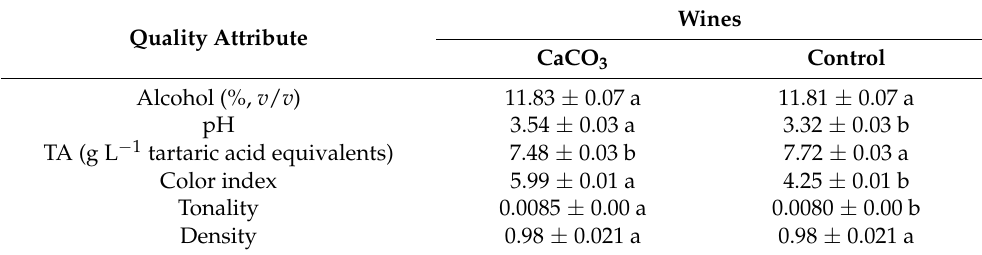
Table 4. Effect of the foliar application of CaCO 3 on general properties of ‘Shiraz’ wine.